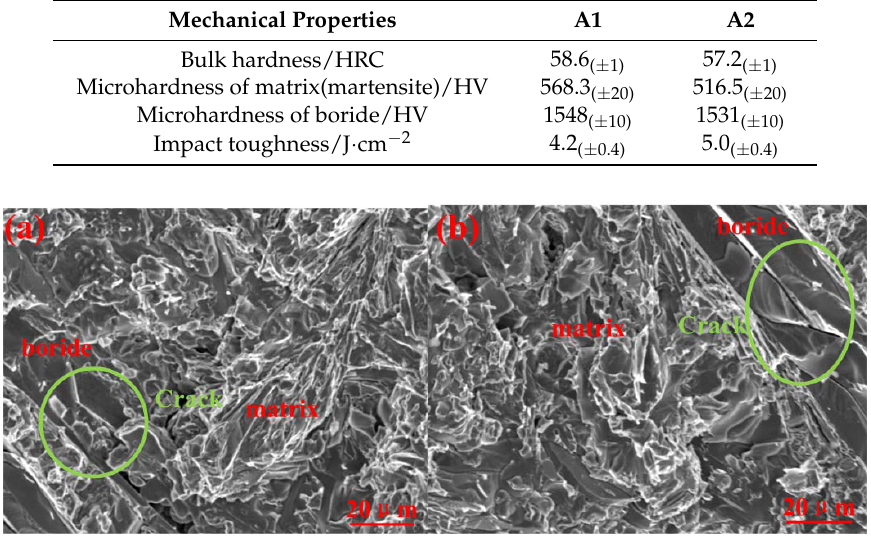
Figure 5. Fracture morphology after the test of impact toughness. ( a ) the A1 sample; and ( b ) the A2 sample.